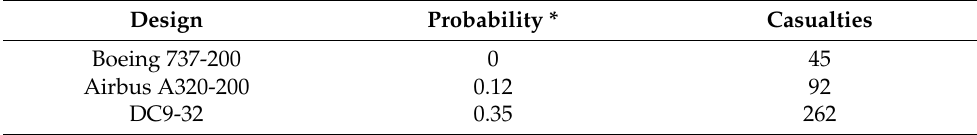
Table 3. Cumulative probability without Boeing 737-Max in the